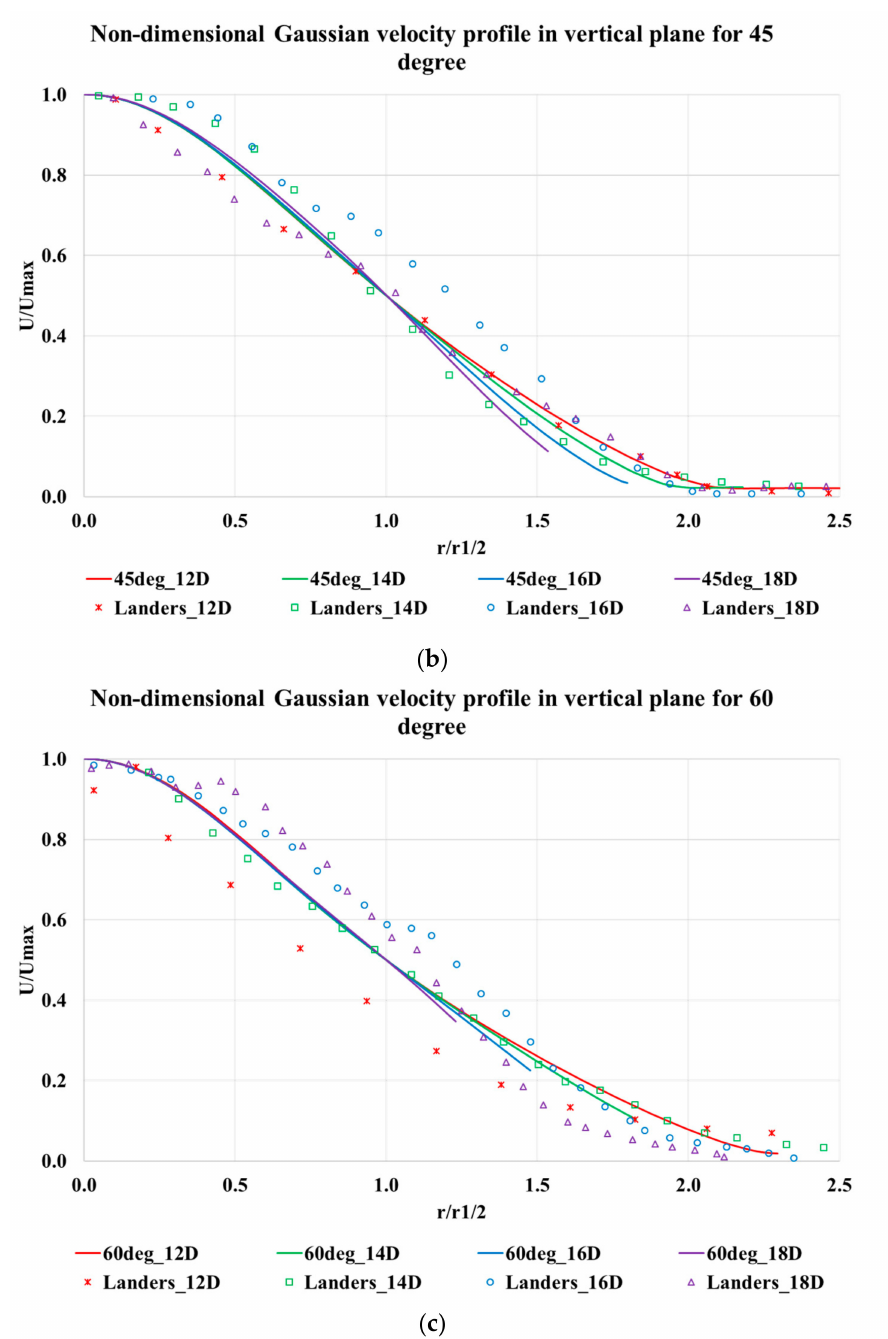
Figure 9. Non-dimensional velocity profile in vertical plane for different impingement angle: ( a ) 30 degree; ( b ) 45 degree; and ( c ) 60